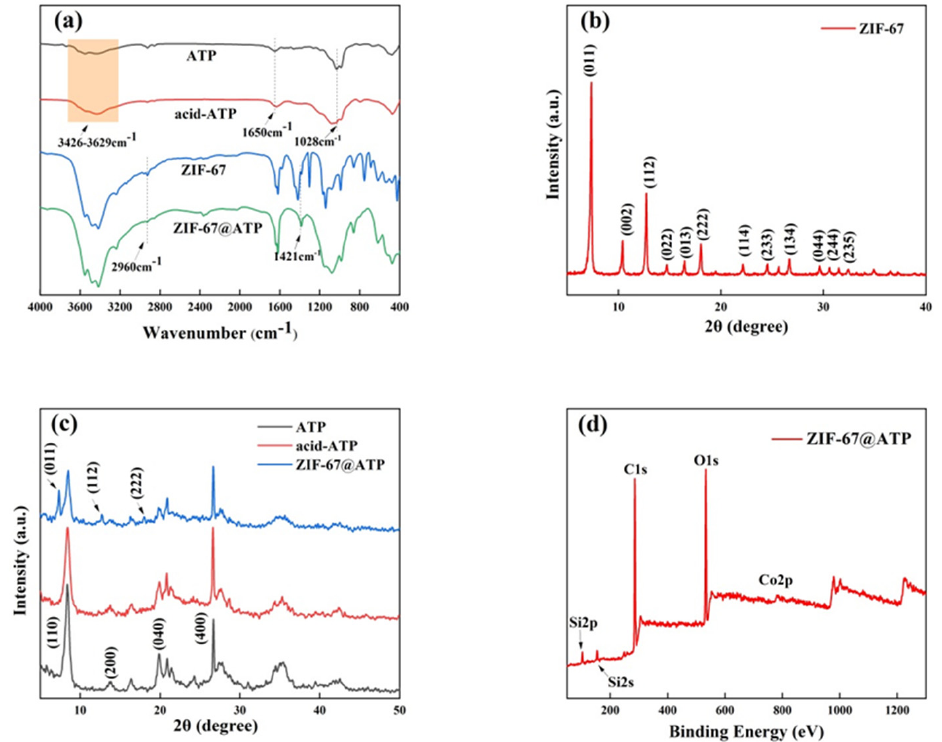
Figure 1. ( a ) FTIR spectra of ATP, acid-ATP, ZIF-67 and ZIF-67@ATP; ( b ) XRD patterns of the ZIF-67; ( c ) XRD patterns of ATP, acid-ATP and ZIF-67@ATP; and ( d ) XPS full spectrum of ZIF-67@ATP. and the corresponding diffractograms are presented in Figure 1b,c. The basal